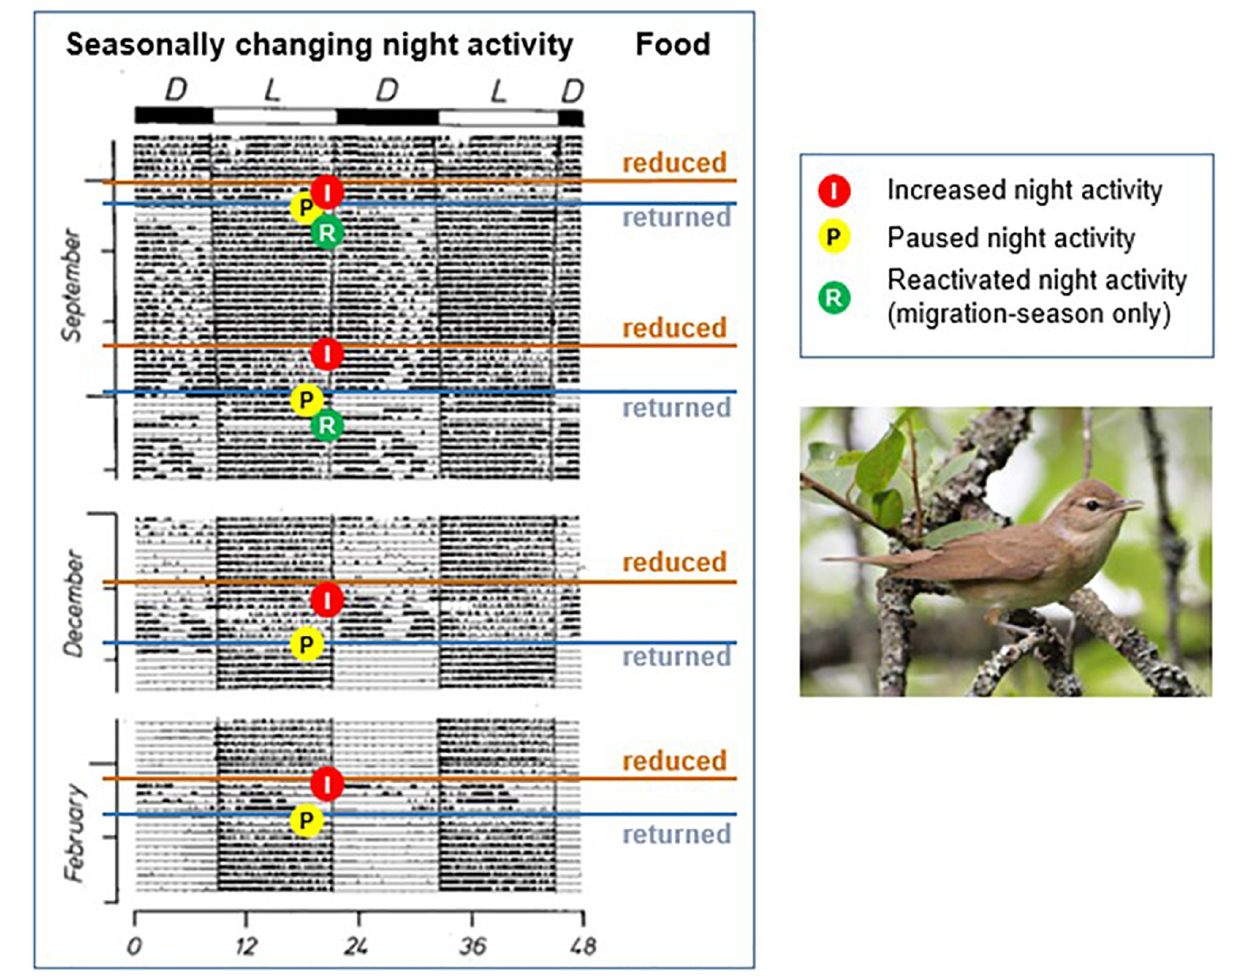
FIGURE 5 | Effects of food on Zugunruhe. Day-night activity shifts of a Garden Warbler in response to experimental changes in food supply. Shown is an actogram which plots activity of the bird (black marks) against time of day ( x -axis) for each day of the experiment, represented by a line. Data are shown for two consecutive days: the second day is repeated as the first day on the successive line; actogram reproduced with kind permission of Oecologia . Inlay: image of Garden Warbler from Billyboy, Sweden, wikimedia.org; based on Gwinner et al.